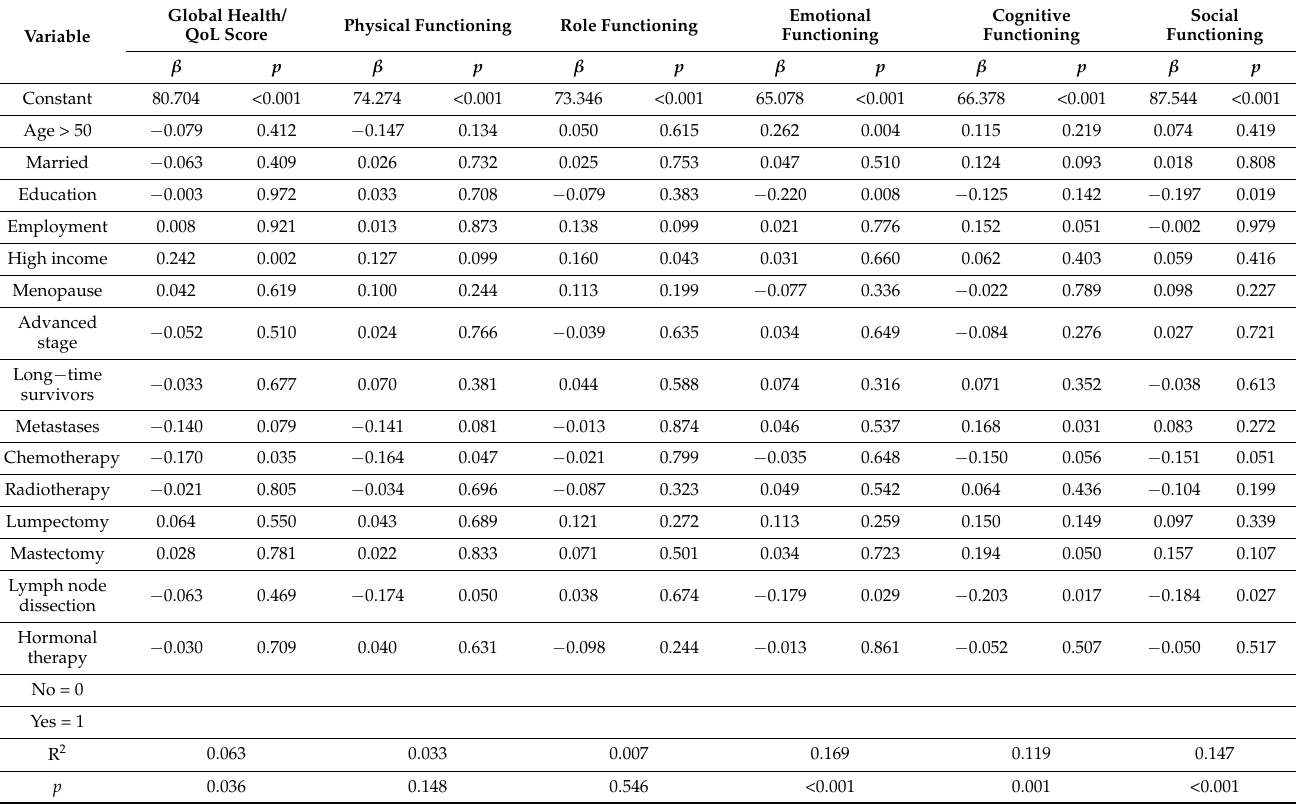
Table 5. Linear regression model with parameter estimates for the QLQ functional